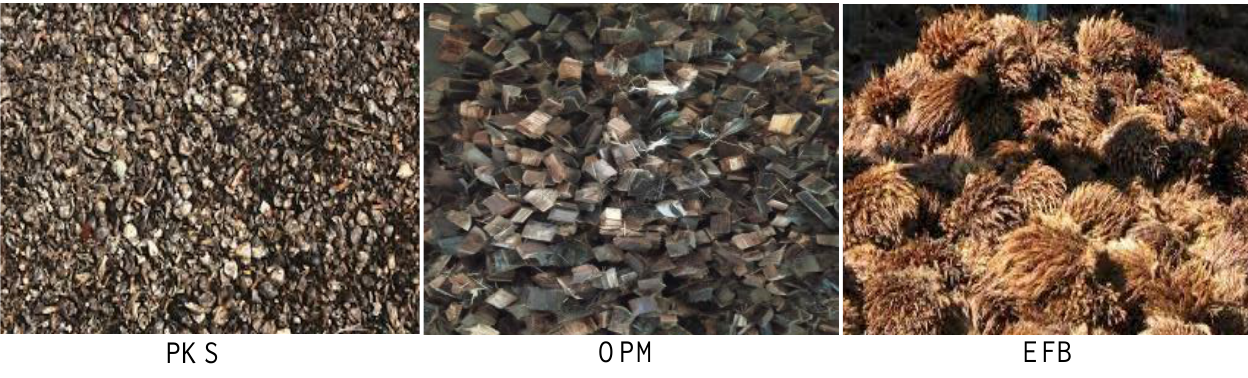
Figure 1. Types of palm oil biomass fuel.